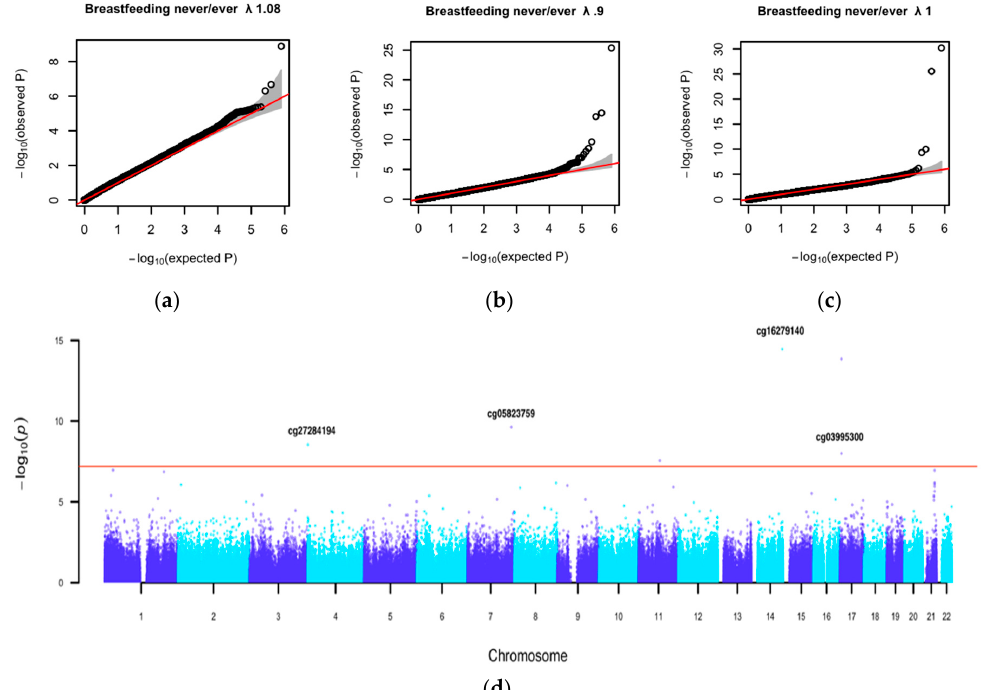
Figure 2. Quantile-Quantile (QQ) plots: ( a ) in the total sample; ( b ) in the subsample of children younger than 10 years old; and ( c ) in the subsample of children older than 10 years old. ( d ) Manhattan plot shows the epigenome-wide association study results of breastfeeding ‘never’/‘ever’ in children younger than 10 years old. Covariates included sex, age, socio-economic status (SES), maternal age at delivery, maternal pre-pregnancy BMI, maternal prenatal smoking, gestational age, EPIC array row and bisulfite sample plate, and cell composition. In the Manhattan plot, the red line represents the Bonferroni threshold (6.34 × 10 –8 ). Given CpG names indicate significant loci after removal of outliers. Genome-wide EWAS test statistics from the analyses of Model 2 (in the total sample and in the children younger than 10 years) showed no inflation (see Figure 2a,b). For four out of the eight significant CpGs, the association disappeared after removal of outliers (see Figures S4 and S5). The four CpGs that were unaffected by outliers were selected for a replication analysis (see Figure S6):